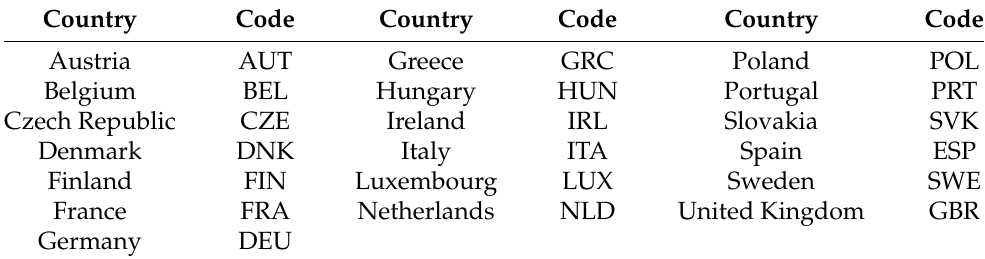
Table 2. Countries in the